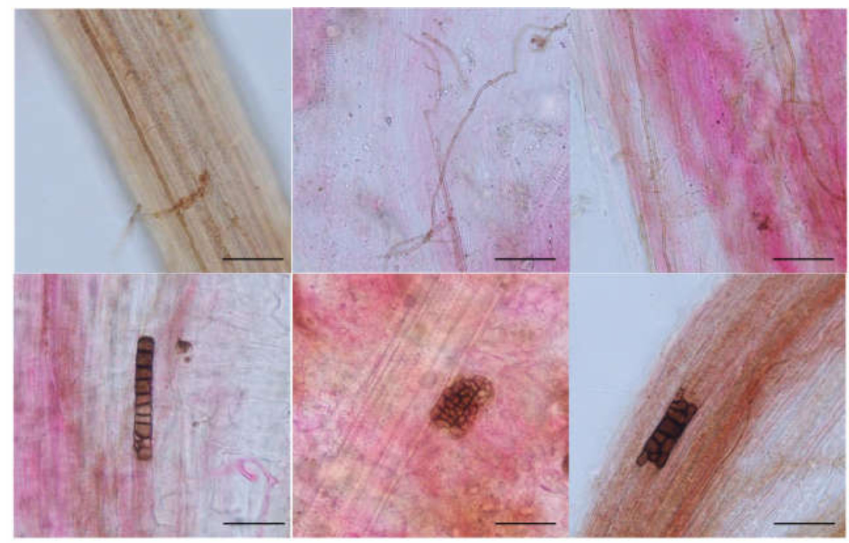
Figure 8. Colonization of DSE strains in the roots of inoculated Artemisia ordosica seedlings after harvest. Note: bars = 50 µ m.